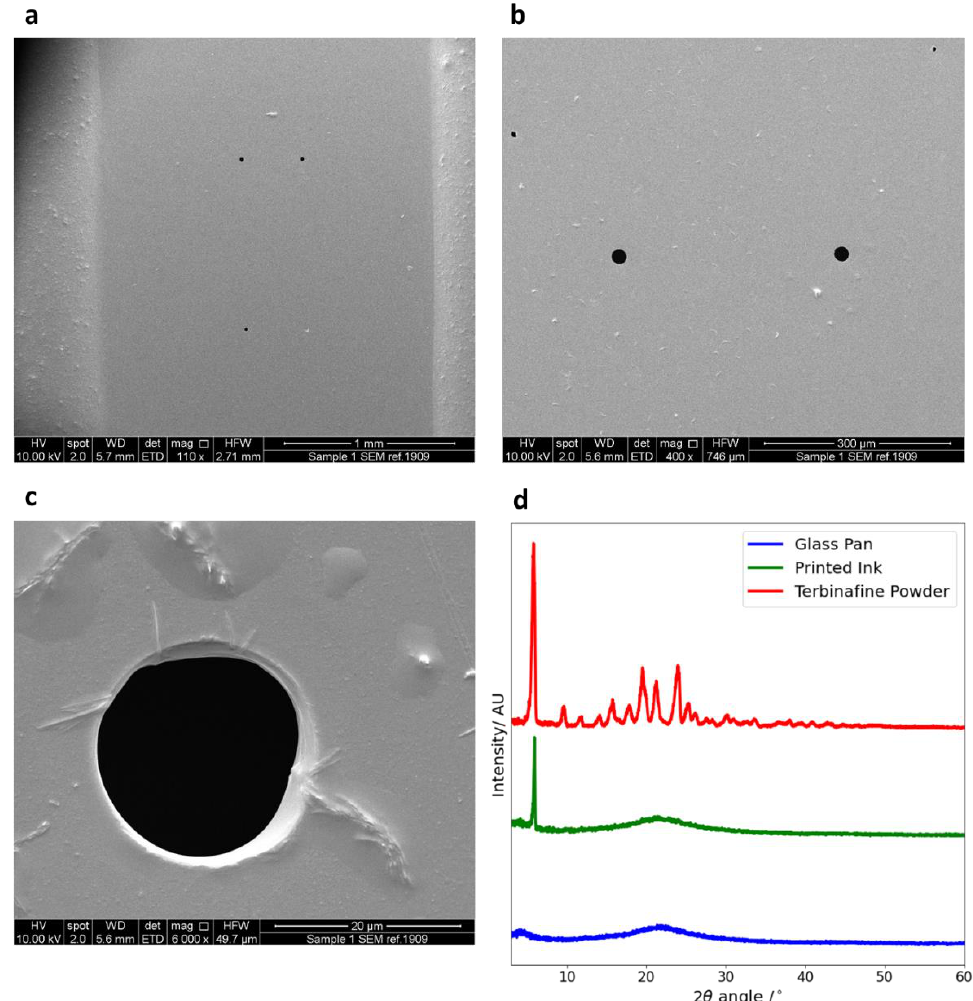
Figure 3. ( a – c ) SEM image taken of the nozzles in order to determine the nozzle diameter. The magnifications are 110 × ( a ), 400 × ( b ) and 6000 × ( c ). Taken across the values, the diameter of the orifice was measured as 21.0 ± 2.2 µm. ( d ) The XRD data for the glass pan, printed ink and terbinafine HCl powder.